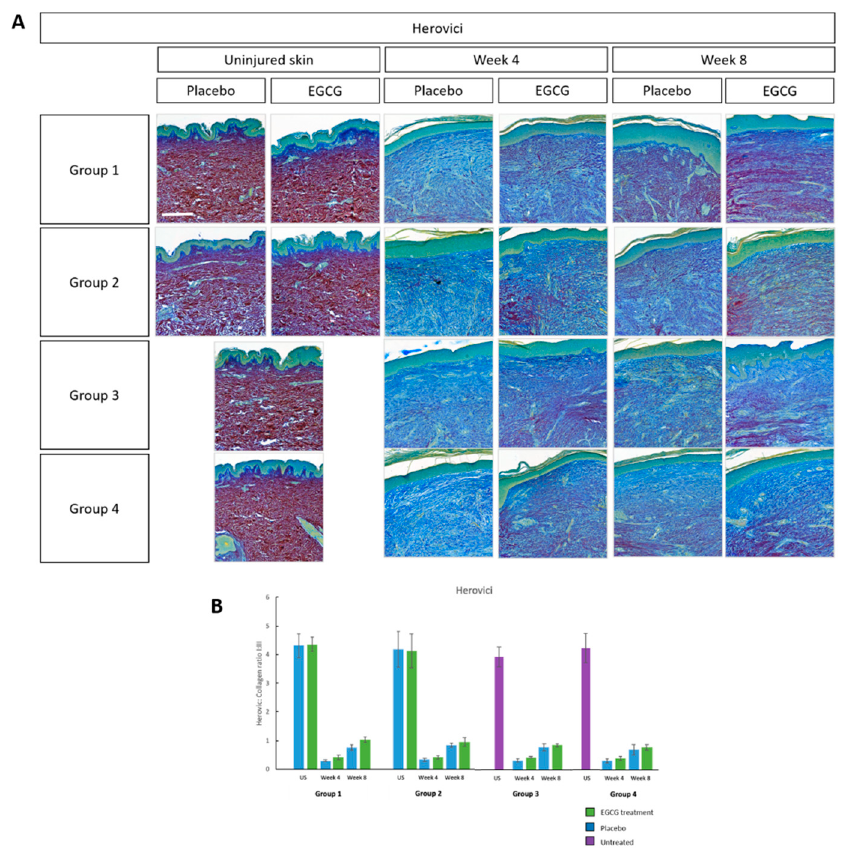
Figure 23. Herovici analysis of topical epigallocatechin-3-gallate (EGCG) versus placebo. ( A ) Herovici images demonstrating mature and immature collagen. ( B ) Herovici collagen I:III ratio analysis. Error bars: mean ± SD. Scale bars = 100 μ m.